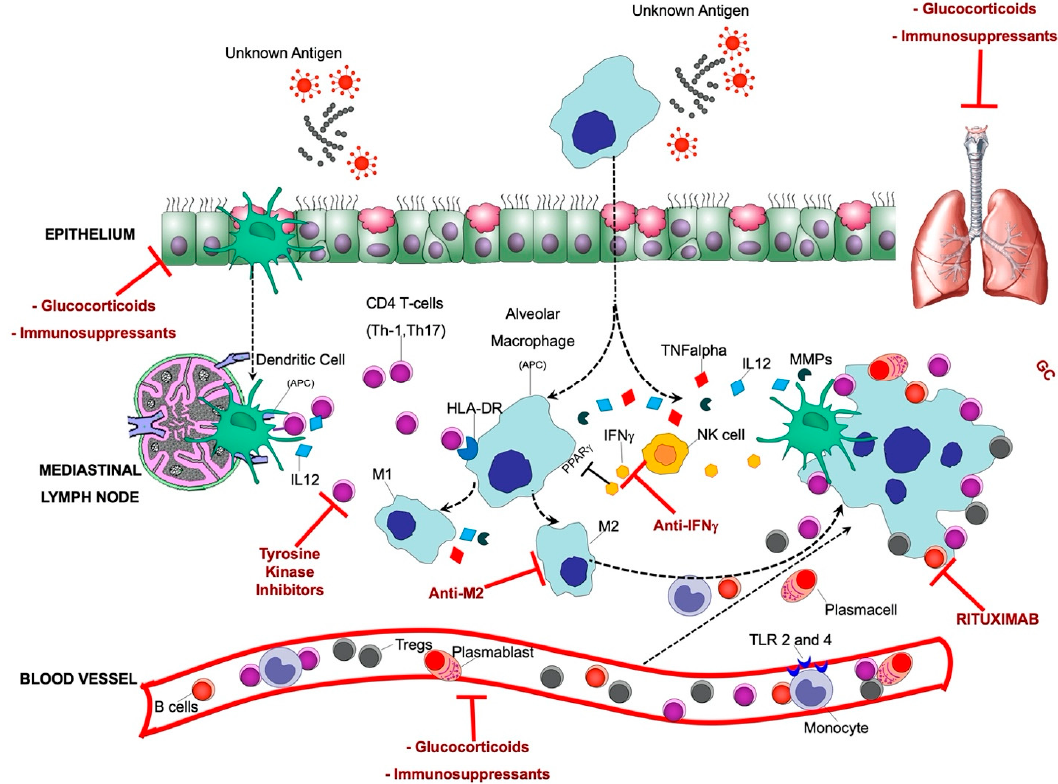
Figure 4. Pathobiology of sarcoidosis and current therapeutic approaches: An unknown airborne-antigen activates interstitial dendritic cells (DCs) and alveolar macrophages (AMs) simultaneously. The interstitial DCs pick up the antigen and migrate toward the mediastinal lymph nodes, where they serve as antigen-presenting cells (APCs) to T helper (Th)1 and 17 cells by initiating their differentiation and clonal expansion. Simultaneously, AMs: (1) serve as APCs together with DCs; (2) differentiate as M1 and M2 macrophages and further induce the inflammatory process (M1), fibroblasts proliferation, and fibrotic tissue deposition (M2); and (3)producethepro-inflammatorycytokinetumornecrosisfactor- α (TNF- α )viahumanleukocyteantigen (HLA)-DR, and other chemoattractants such as IL-12 under stimulation of both TNF- α and natural-killer (NK) cell-derived interferon- γ (INF- γ ). Persistent stimulation, mediated by APCs leads to continuous recruitment of B cells, plasmacells, Th1 / 17 cells, monocytes (expressing higher Toll Like Receptor (TLR)2 and TLR4, inducing Th1 and Th2 responses, respectively), and regulatory T cells (Tregs) from the